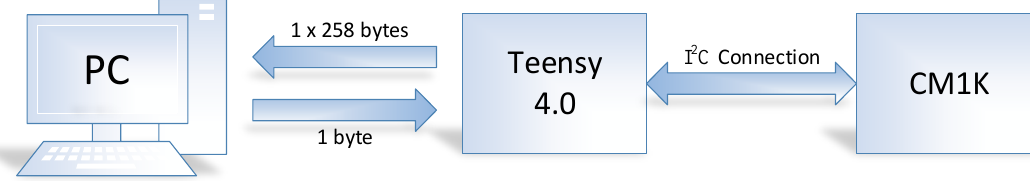
Figure 10. PC-CM1K communication system.